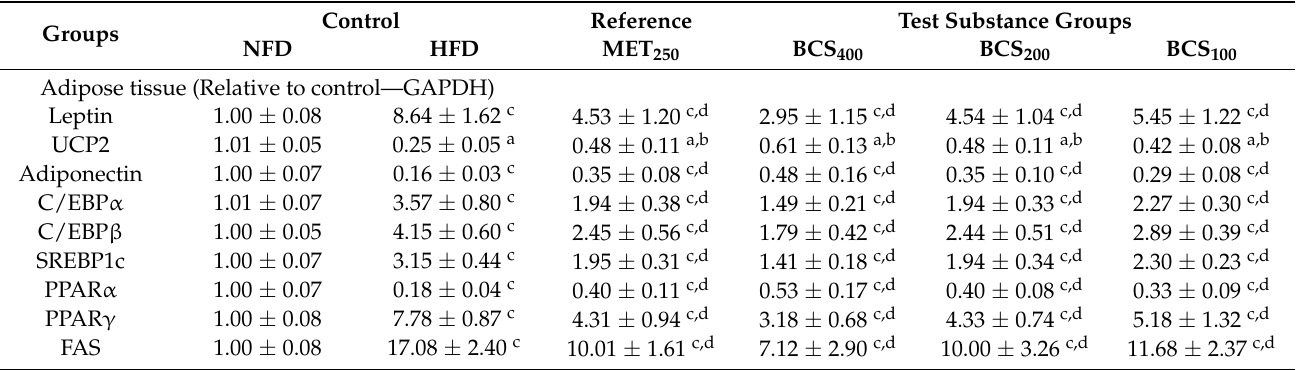
Table 11. The mRNA expressions of lipid metabolism-related genes in adipose tissue of the HFD- and NFD-supplied